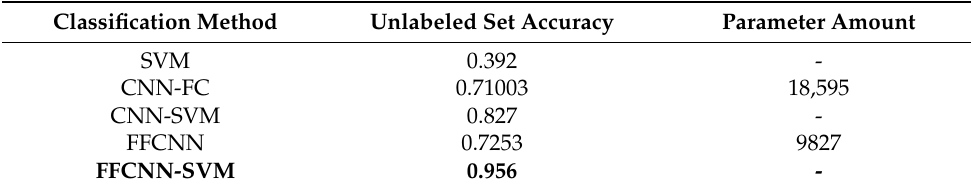
Table 3. Classification accuracy of different methods for unlabeled sample sets.